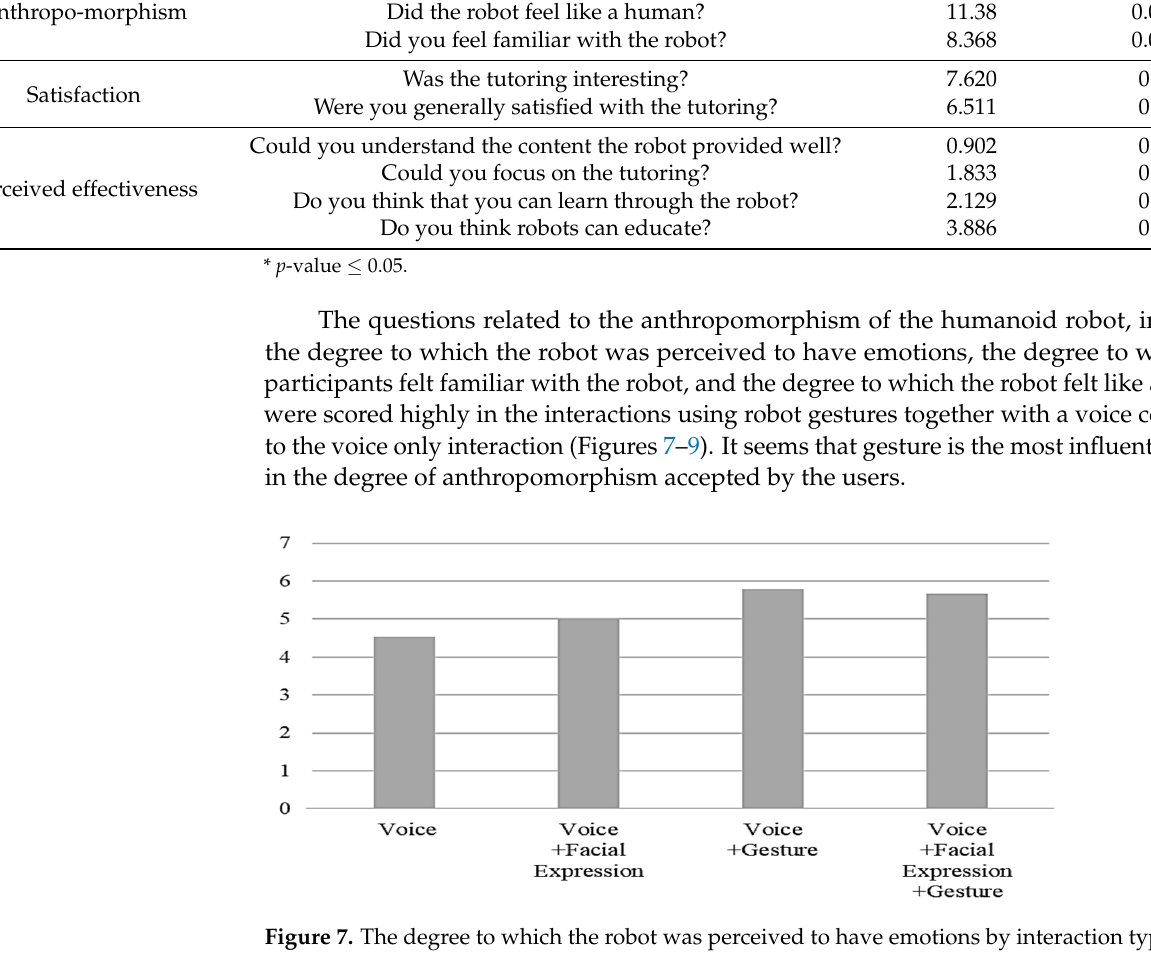
Figure 8. The degree to which the robot felt like a human by interaction type.